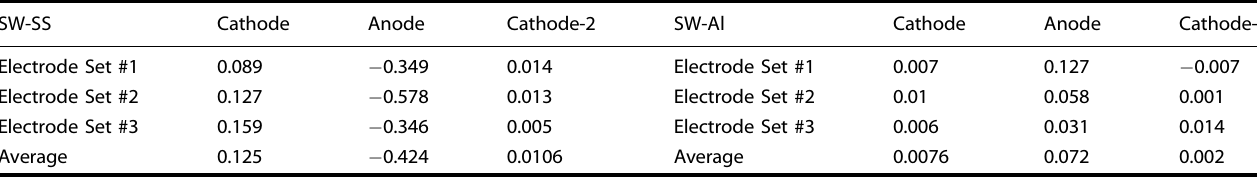
Table 2. Average gain (positive values) or loss (negative values) of electrode mass in grams.